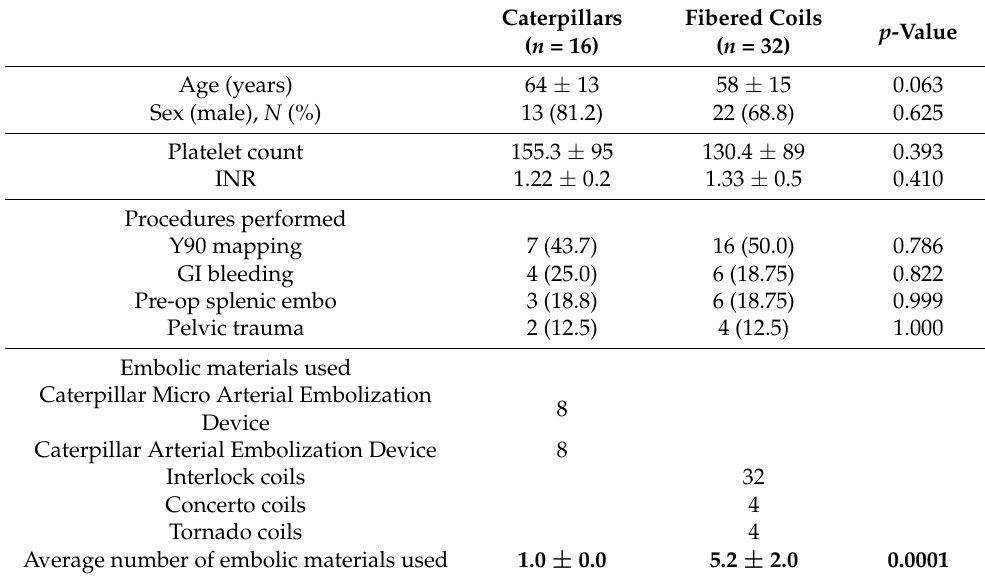
Table 1. Patient demographics and baseline clinical characteristics of the